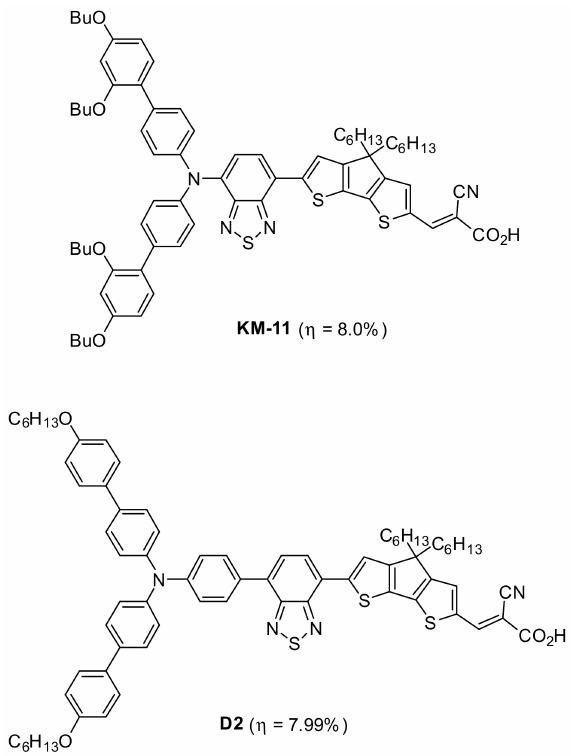
Figure 1. Comparing N- and C-donor attached D-A- π -A